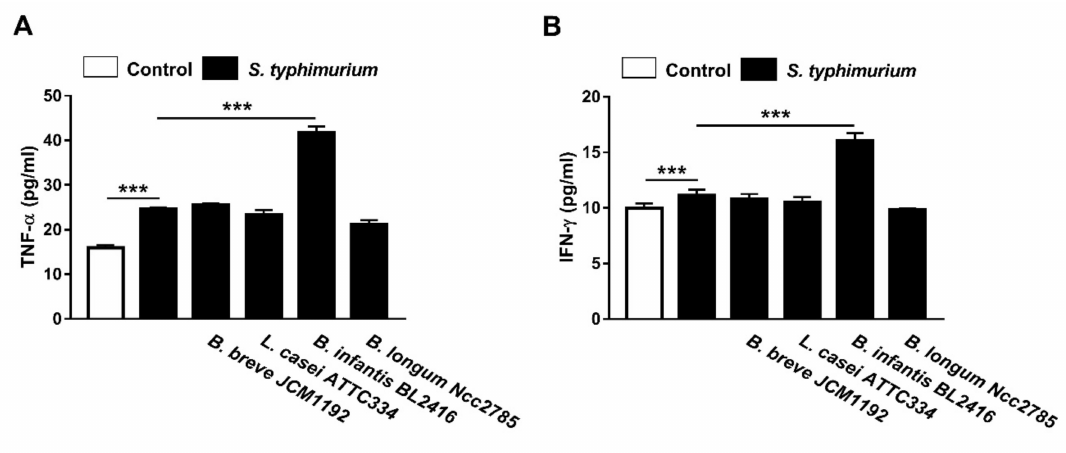
Figure 3. E ff ect of oral administration of di ff erent probiotics on ( A ) TNF- α and ( B ) IFN- γ levels in the peripheral blood of broiler chickens. Data are mean ± SD, ( n = 10). *** p <